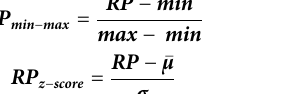
FIGURE 2 The architecture of 3DRP Inception ResNet (Stem, Inception ResNet models A-C , Reduction models A and B , and Prediction